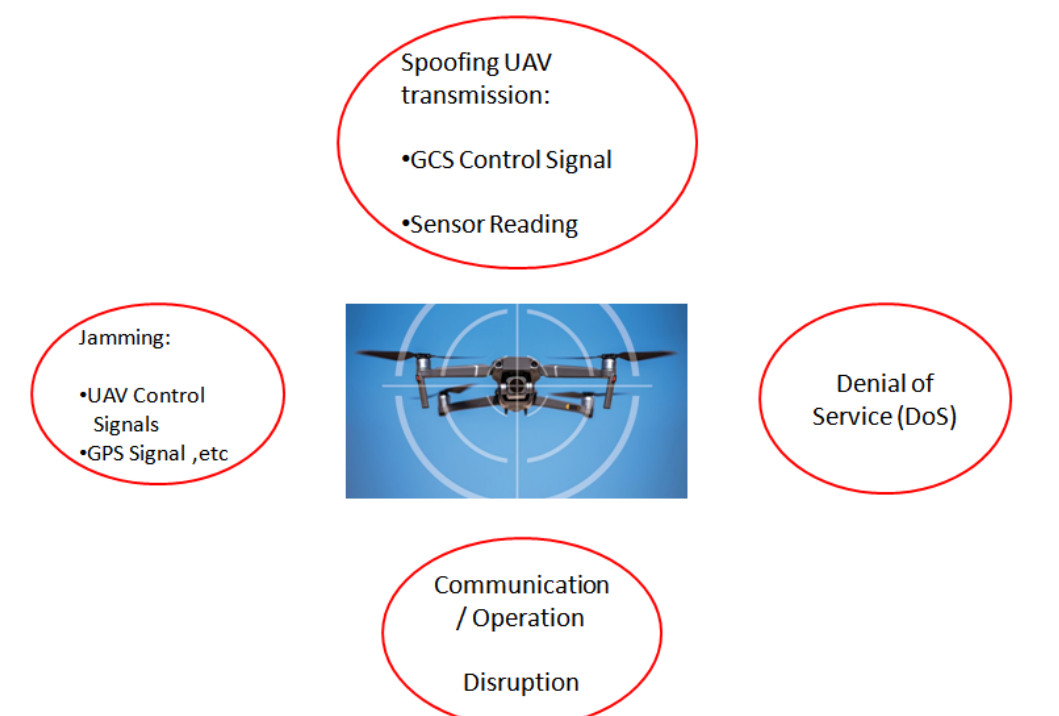
Figure 7. Security challenges in UAV communication.